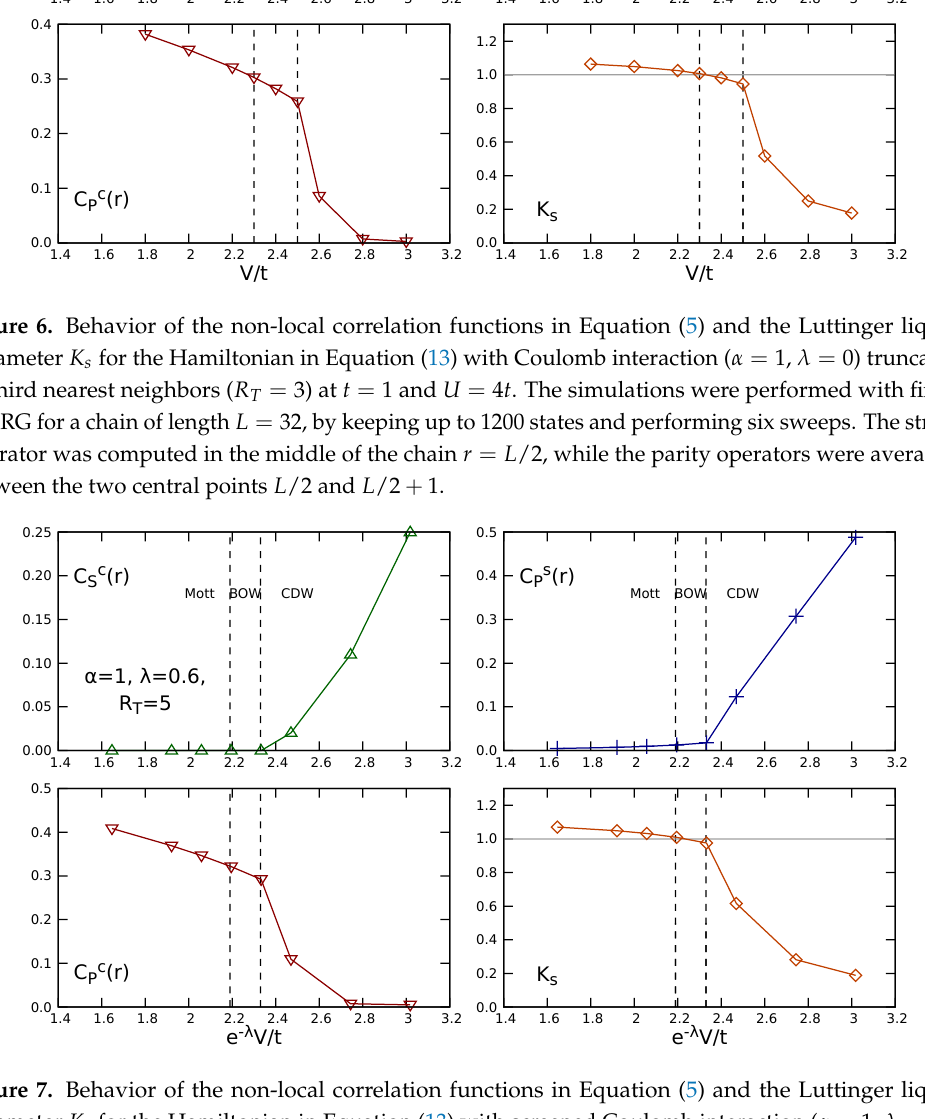
Figure 7. Behavior of the non-local correlation functions in Equation (5) and the Luttinger liquid parameter K s for the Hamiltonian in Equation (13) with screened Coulomb interaction ( α = 1, λ = 0.6) truncated to fifth nearest neighbors ( R T = 5) at t = 1 and U = 4 t . The simulations were performed with finite DMRG for a chain of length L = 24, by keeping up to 1400 states and performing eight sweeps. The string operator was computed in the middle of the chain r = L /2, while the parity operators were averaged between the two central points L /2 and L /2 +